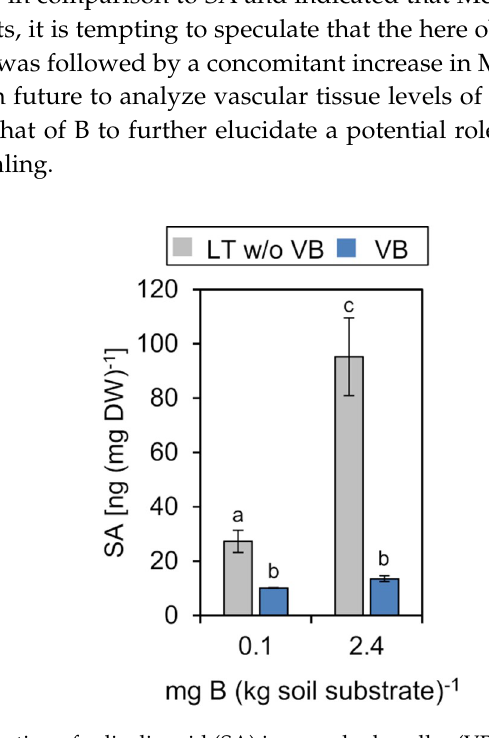
Figure 7. The concentration of salicylic acid (SA) in vascular bundles (VB) or leaf tissue without VB (LT w/o VB) of P. major plants grown on low B (0.1 mg B (kg soil substrate) −1 ) or B-sufficient (2.4 mg B (kg soil substrate) −1 ) soil substrate. Error bar labels with different letters indicate significant differences at p < 0.05 between treatments and tissues according to One-way ANOVA with post-hoc Tukey test.